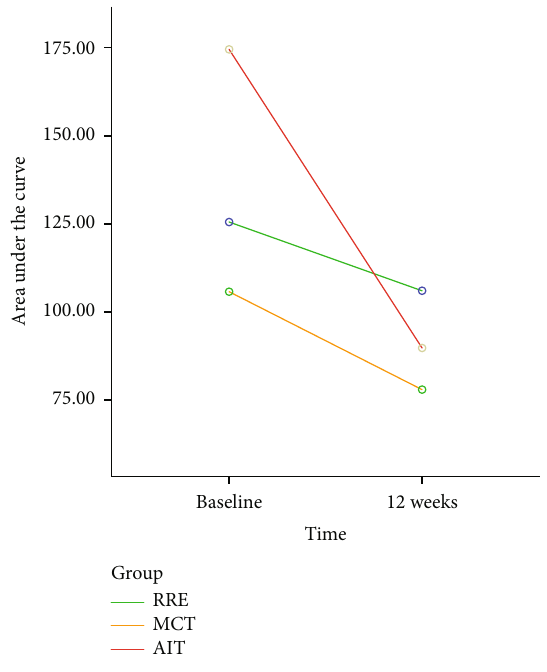
Figure 1: Area under the curve is expressed as Lactate in (mmol/L) x minutes and plotted at baseline and 12 weeks on the x -axis. RRE is recommendation of regular exercise training home-based exercise training without supervision. MCT is moderate continuous exercise training. AIT is aerobic interval